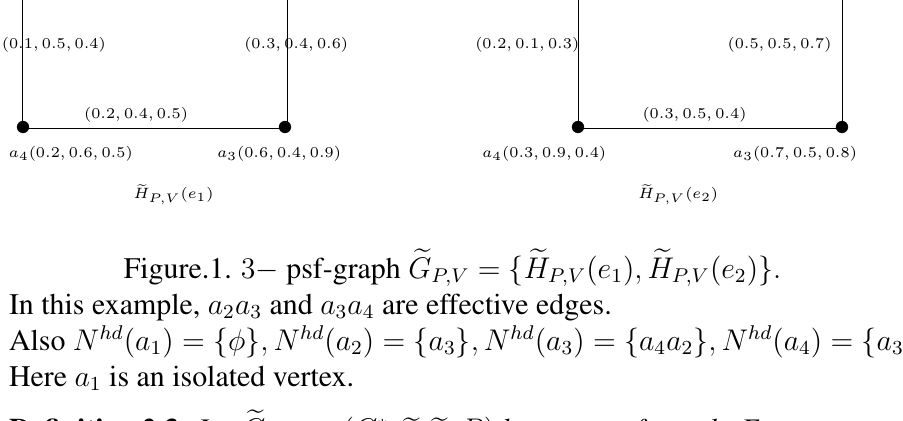
Figure.1. 3 − psf-graph (cid:101) G